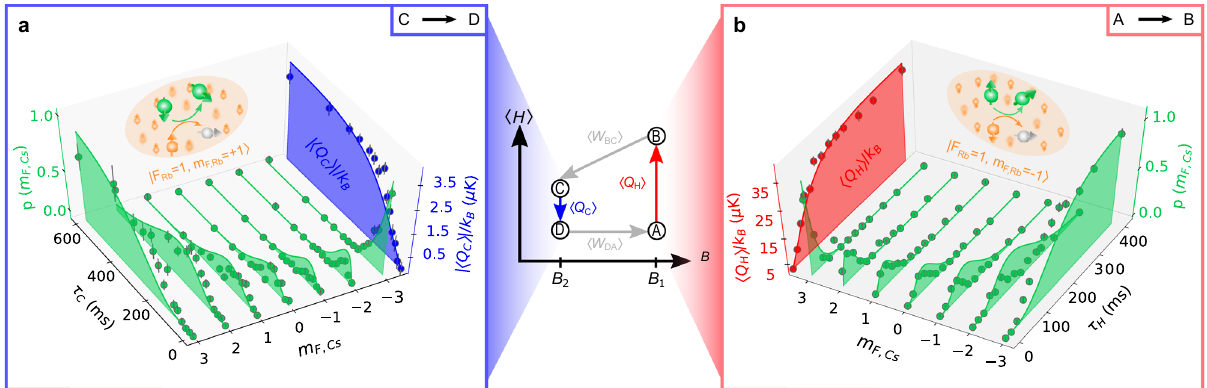
Fig. 2 Full-counting statistics of heat exchange. During the heating (AB) and cooling (CD) steps of the quantum Otto cycle (center), heat is exchanged with the bath. The average population dynamics of the individual engine levels are shown in green. The mean heats, 〈 Q C 〉 and 〈 Q H 〉 , extracted from the full- counting statistics are indicated for a cooling (blue) and b heating (red), as a function of the respective times τ C and τ H . Dots show the experimental data, solid lines are a prediction of a microscopic model (Methods). In both panels, the population dynamics shows the transition from an initially spin-polarized engine state via a state of many populated m F levels to a spin-polarized state of the other extreme spin state. The inversion of an initially fully